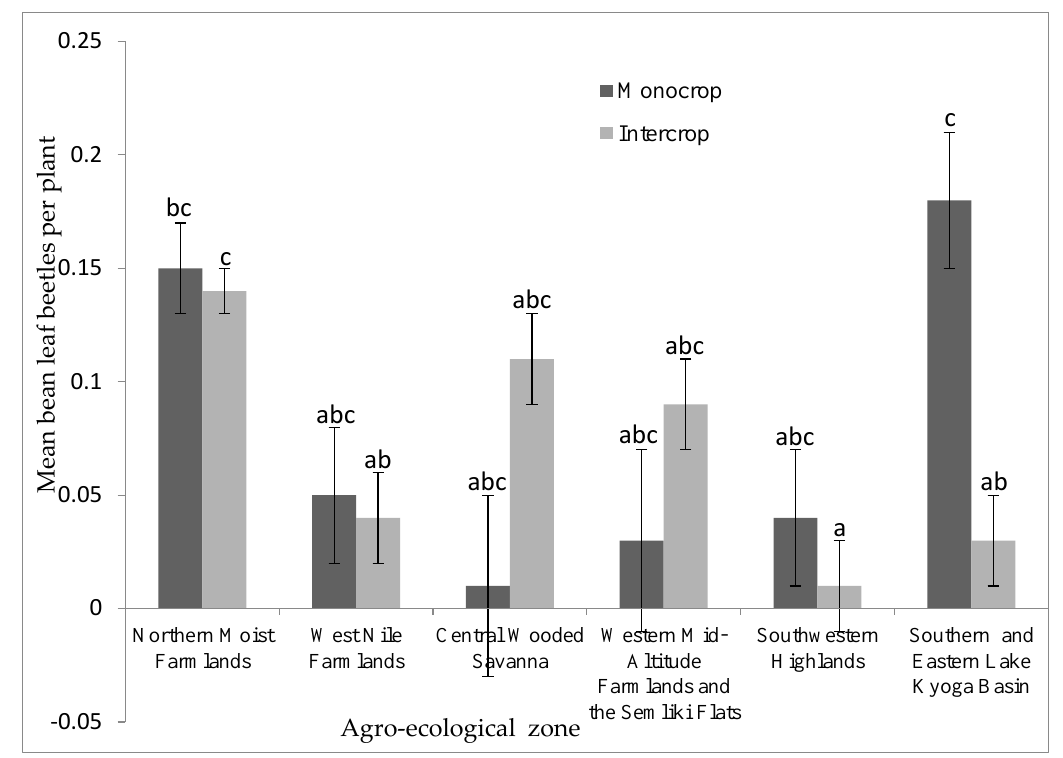
Figure 8. Incidence of bean leaf beetles under different cropping systems in different agro-ecological zones in Uganda. Bars bearing the same letter or letter combinations are not significantly different at p = 0.05.